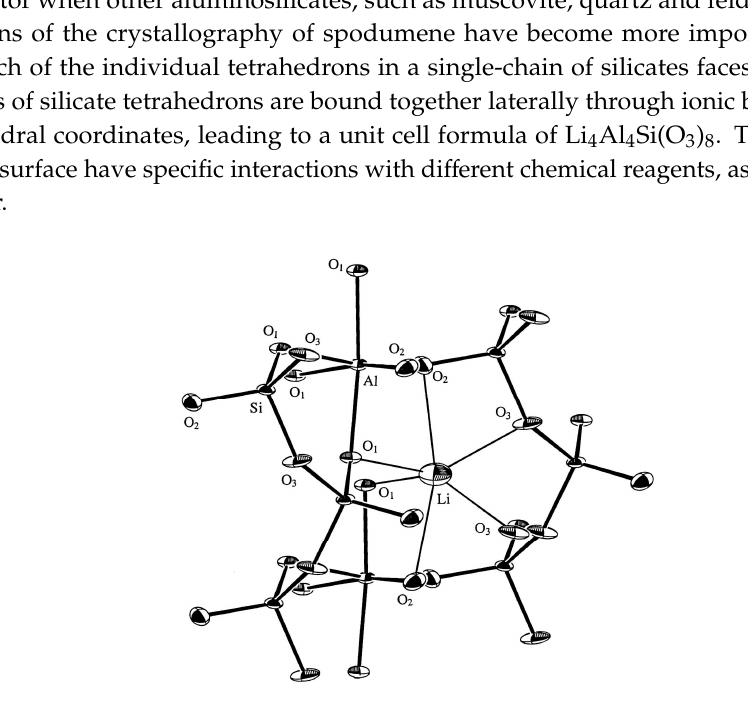
Figure 1. The crystallographic structure of spodumene [7].